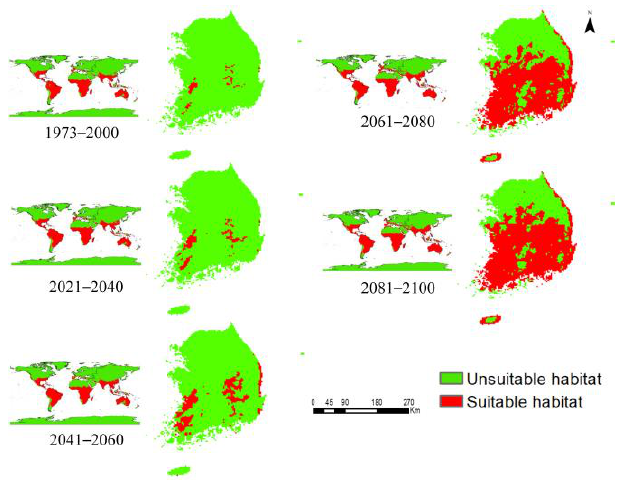
Figure 2. Potential distribution of P. hysterophorus around the world and in South Korea under the current climate (1973 – 2000) and future climate scenario (SSP2-4.5; 2021 – 2040, 2041 – 2060, 2061 – 2080, and 2081 – 2100). Green and red colors indicate the unsuitable and suitable habitats for P. hysterophorus , respectively.